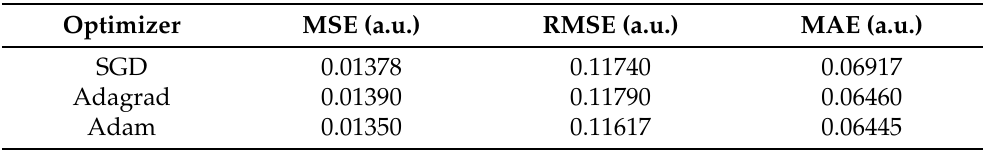
Table 7. Average of each model on evaluation metrics when predicting D in the test dataset under different combinations of